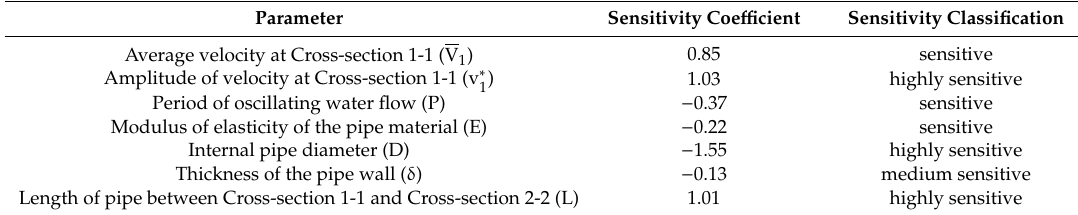
Table 10. Sensitivity classification of the seven parameters in Equation